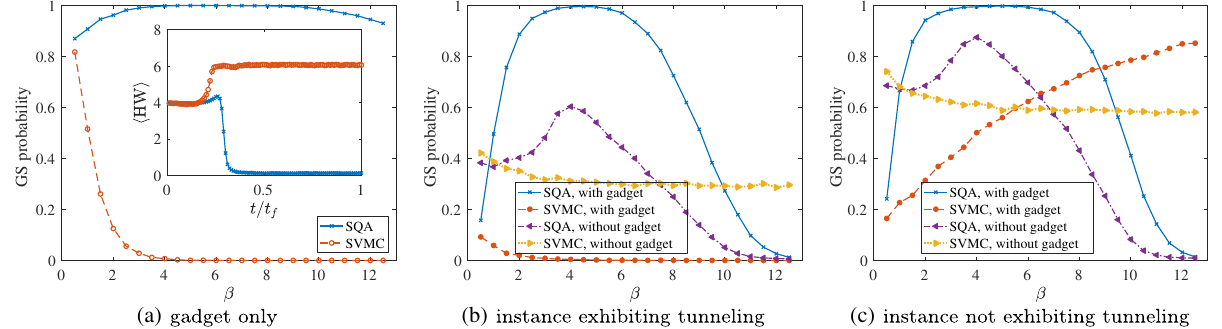
FIG. 6. Probability of reaching the ground state (GS) at the end of the anneal using SVMC and SQA for different simulation inverse temperatures β . (a) Simulation results for the 8-qubit gadget only. SQA ’ s success probability increases over a wide range of decreasing temperatures, whereas the SVMC algorithm rapidly deteriorates as the temperature decreases. Inset: Expectation values of the Hamming P n weight operator HW ¼ 1 ð 1 − σ z Þ for the 8-qubit gadget for SVMC and SQA using β ¼ 2 . 5 . Compare to the behavior of the 2 i i ¼ 1 ground state and first excited state shown in Fig. 4. For the SVMC algorithm, to compute the expectation value of the Hamming weight operator at intermediate s values, we can either project the state to the computational basis (shown) or use the spin-coherent state; the results are almost indistinguishable. For SQA, we average over the Hamming weight of the configurations in the imaginary-time direction. (b),(c) Probability of reaching the ground state at the end of the anneal using SVMC and SQA for different simulation inverse temperatures β using two different instances, with and without the 8-qubit gadget, at the largest available size L ¼ 16 . (b) An instance that exhibits a clear signature of a tunneling energy barrier when the gadget is introduced. (c) An instance that does not exhibit a signature for a tunneling energy barrier even with the gadget. In all panels, SVMC and SQA simulations used 8 M and 3 M sweeps, respectively, and both algorithms use the DW2KQ annealing schedule. The drop in success probability at large β for SQA is because spin updates become less efficient at high β and more spin updates are required to maintain the high success probability.